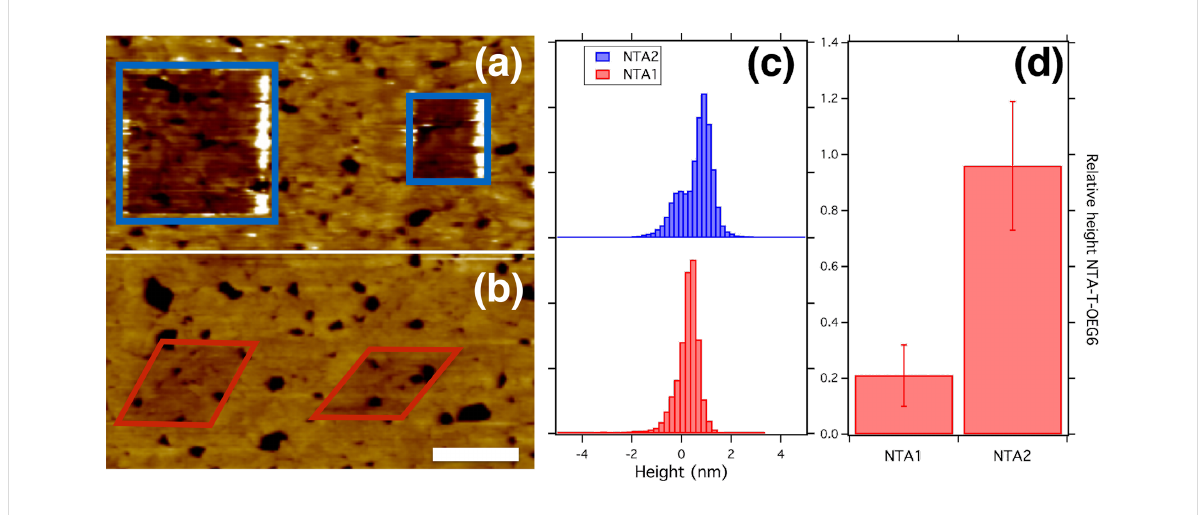
Figure 3: (a) Atomic force microscopy image showing two nanografted patches of T-OEG6 in a NTA2 SAM (b) the same for a NTA1 SAM. The white scale bar corresponds to 1 μ m. (c) Height histograms corresponding to the AFM images in (a) and (b). The reference has been set at the center of the Gaussian distribution related to the squared dark areas in the images. (d) Synthesis of histogram analysis for the NTA1 and NTA2 samples investigat- ed providing the average values of Δ h NTA − TOEG6 and Δ h NTA1 − TOEG6 (for details see the text).